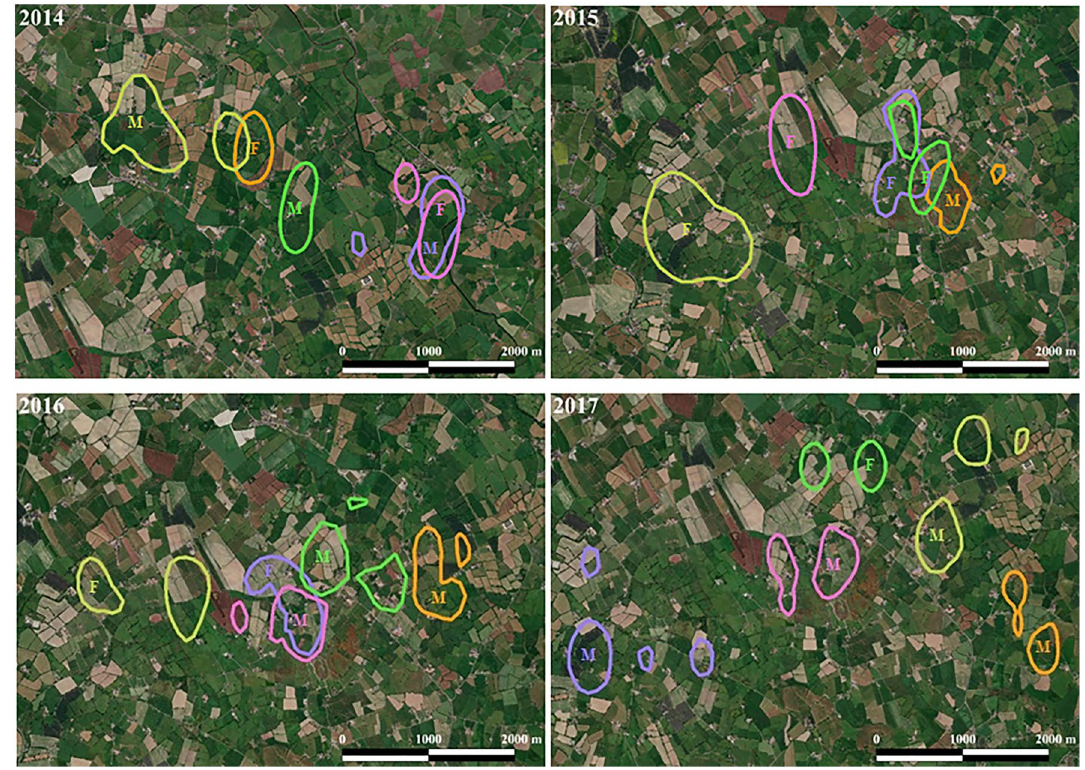
Figure 4. Example of 50% core ranges of 5 badgers for 2014–2017 created using QGIS version 3.8.1 (basemap satellite imagery ERSI World Imagery map) (https:// www. qgis. org/ en/ site/ and https:// www. arcgis. com/ home/ item. html? id= 10df2 279f9 684e4 a9f6a 7f08f ebac2 a9). Individuals within each year are denoted with a colour overlaid the core region used. Year is denoted in the top left corner of each panel. Sex is denoted by M (male) and F